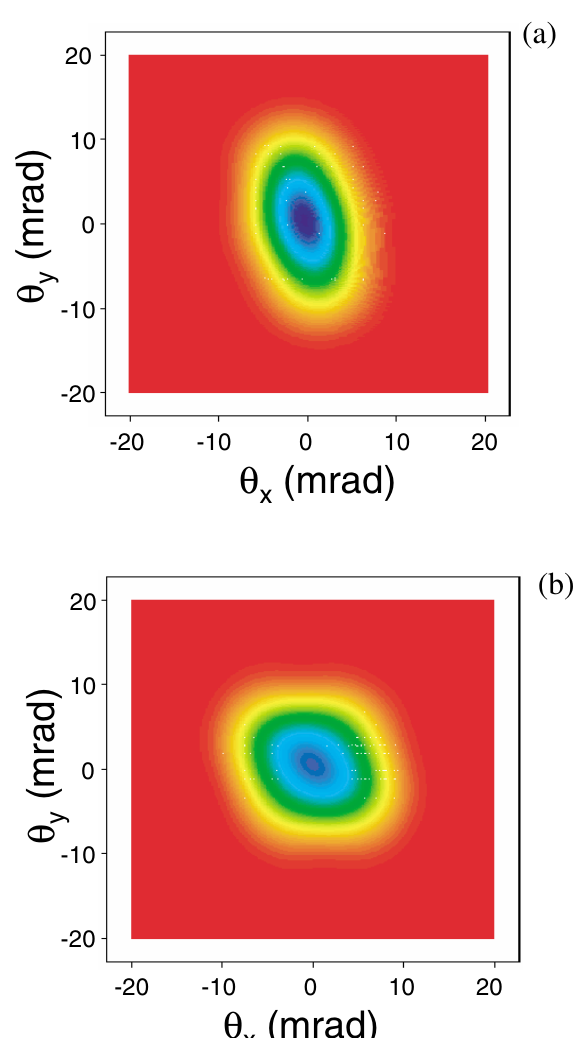
FIG. 6. (Color) Theoretical intensity profiles determined from the measured laser and electron beam parameters for the case of an x polarized incident laser pulse (a), which corresponds to the measured case (Fig. 2), and a y polarized laser pulse